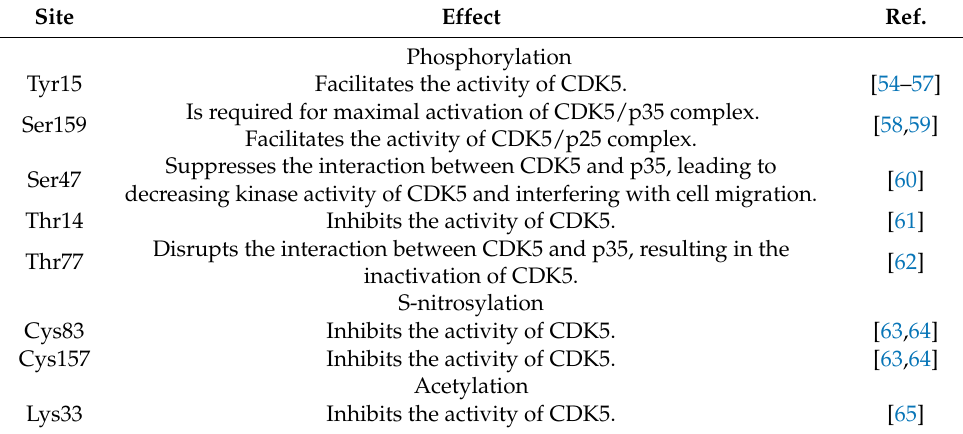
Table 2. The regulation of CDK5 by posttranslational